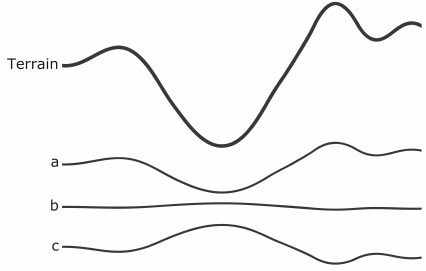
Figure 2. Profiles selected from global data sets, showing topography (“Terrain”) and 3 out of 20 Bouguer anomalies, computed using different bulk densities. (a) Applied bulk density too high (b) Applied bulk density just about right. (c) Applied bulk density too low. The best-fit density is found by two different techniques, minimizing the correlation between topography and Bouguer anomalies (sec. 3.1) or by maximizing smoothness of the Bouguer anomalies (sec. 3.2).